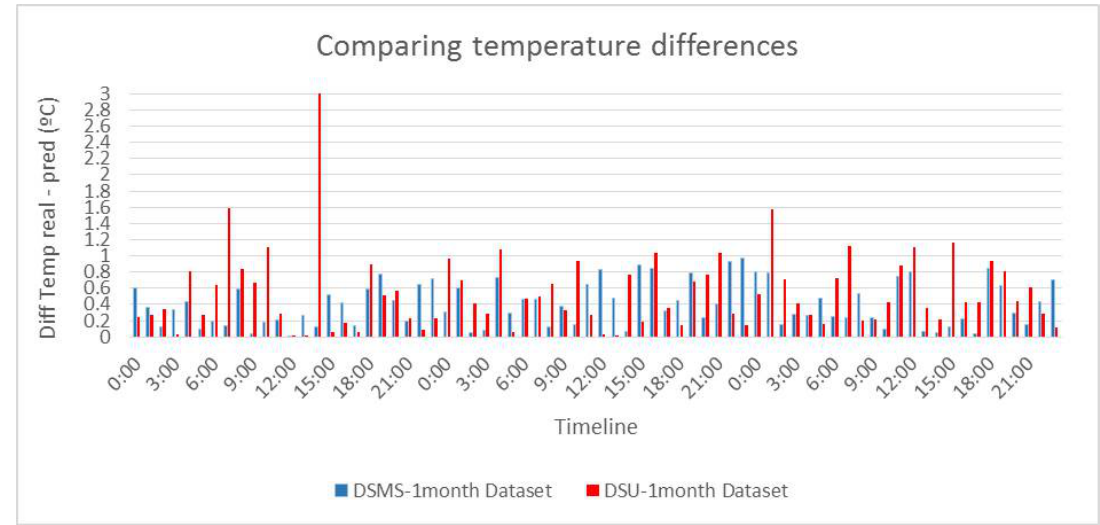
Figure 6. Comparison of the error between the real and the predicted temperature values by the models (under testing) generated with the DSMS-1-month and DSU-1-month